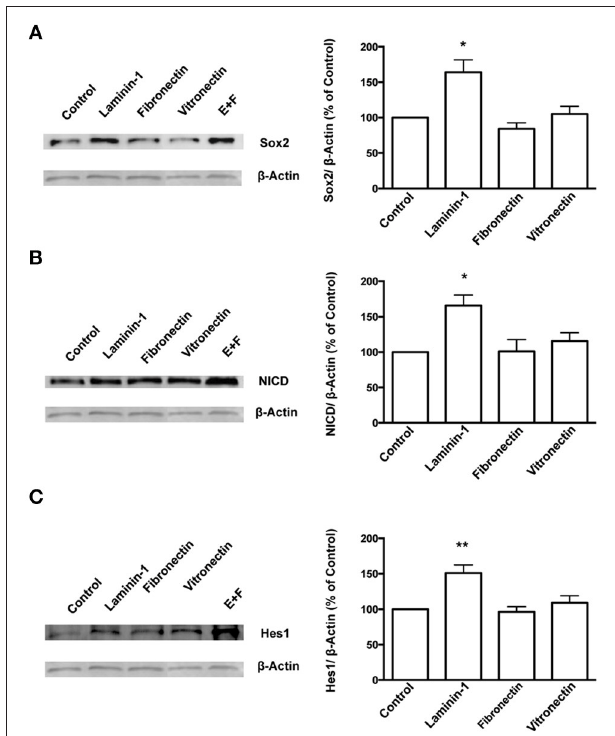
FIGURE 6 | Laminin-1 activates the Notch signaling pathway and sustains stemness in SVZ cells. Western blots (left) and respective quantification (right) of protein levels of Sox2 (A) , NICD (B) , and Hes1 (C) in SVZ cells plated for 24 h on poly-D-lysine (control), laminin-1, fibronectin, or vitronectin. Bar graphs show the quantification of protein levels relative to levels obtained in cultures plated onto poly-D-lysine. Quantifications in free-floating neurospheres cultured in the presence of EGF and FGF-2 (E + F) were used as a positive control. * P < 0.05 and ** P < 0.01 using one-way ANOVA for comparison to values obtained in cultures plated onto